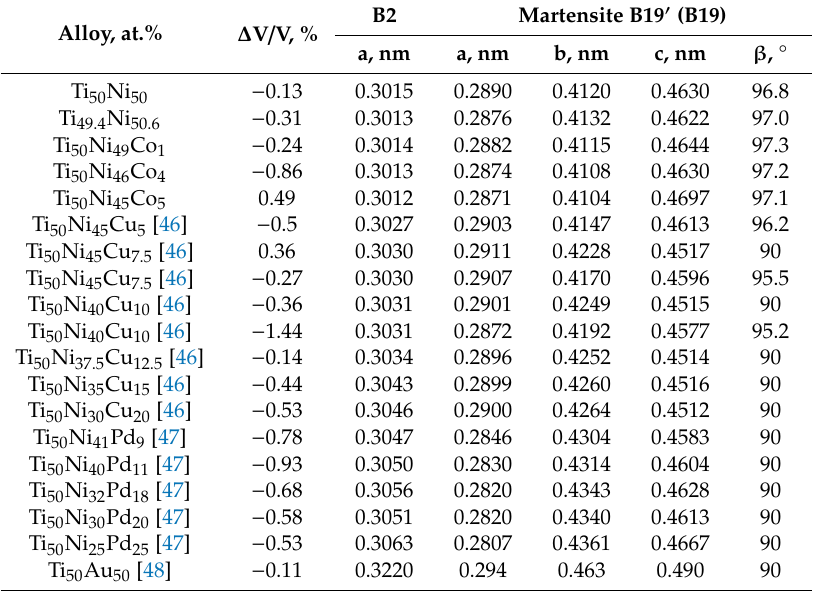
Table 6. The magnitudes of the volume e ff ect (V / V) and lattice parameters of the B2 austenite and of the B19, and B19 (cid:48) martensites near the M s temperature of the binary and ternary TiNi-based alloys. B2 Alloy, at.% ∆ V / V, %